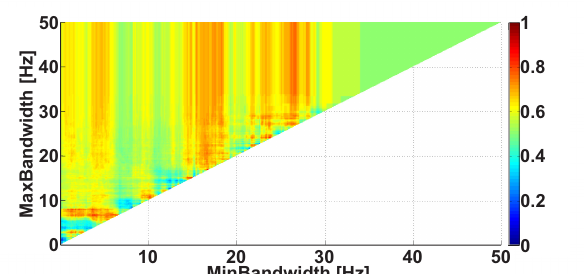
Figure 10. An example of the Bandwidth AUC diagram. The abscissa axis indicates the lower bound of the bandwidth; the ordinate axis indicates the upper bound of the bandwidth. The diagram demonstrates the multidirectional